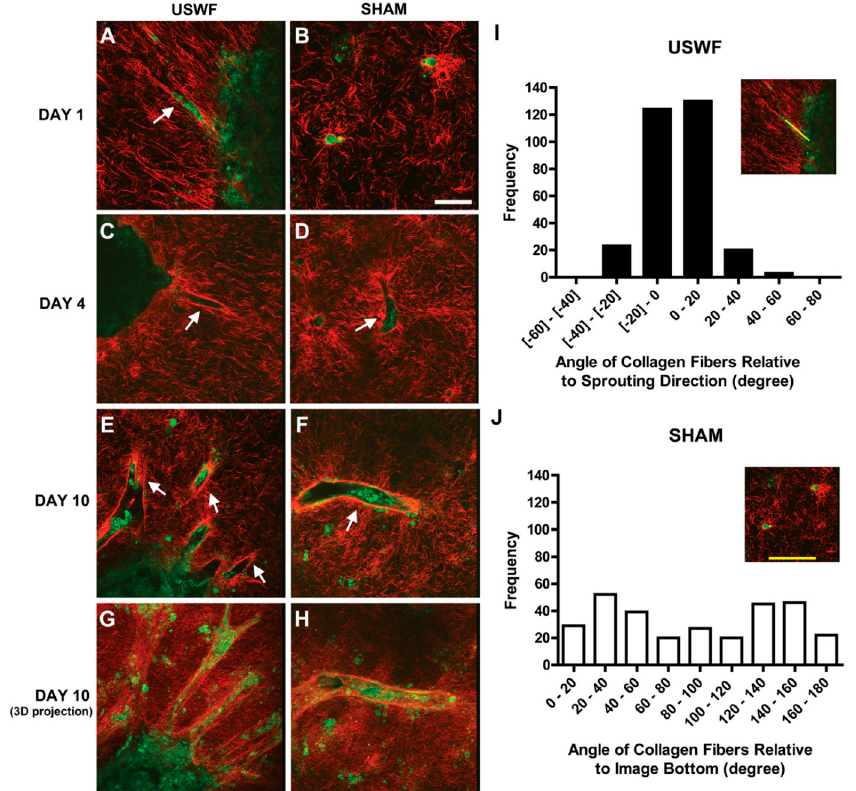
Figure 8. Intrinsic cellular autofluorescence in second-harmonic generation microscopy of endothelial cell bands (green) suspended in unpolymerized collagen type-I fibers (red) on ( A , B ) day 1; ( C , D ) day 4; and ( E , F ) day 10 incubation treated by ultrasound standing wave field (USWF) or sham-exposure, arrows show endothelial cell sprouts in scale bar of 50 μ m, and the histograms of the occurrence frequency of collagen fiber angles in ( I ) USWF- and ( J ) sham-exposed constructs. collagen gels, courtesy of [76].